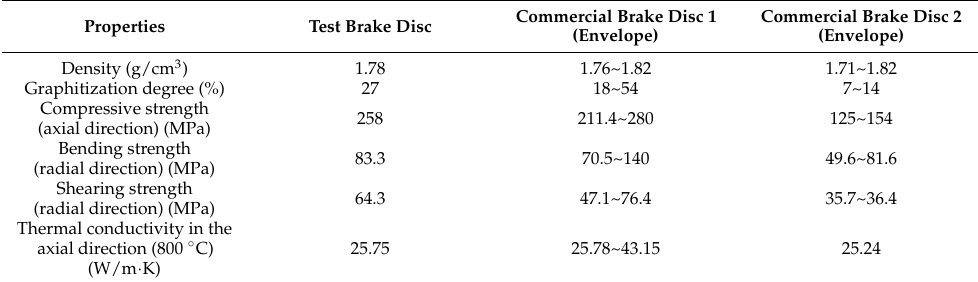
Figure 6. Fracture surfaces of the three brake discs: ( a ) bend fracture of the test brake disc; ( b ) shear fracture of the test brake disc; ( c ) compression fracture of the test brake disc; ( d ) bend fracture of commercial brake disc 1; ( e ) shear fracture of commercial brake disc 1; ( f ) compression fracture of commercial brake disc 1; ( g ) bend fracture of commercial brake disc 2; ( h ) shear fracture of commercial brake disc 2; ( i ) compression fracture of commercial brake disc 2. Table 3. Physical, mechanical and thermal properties of the three different types of brake